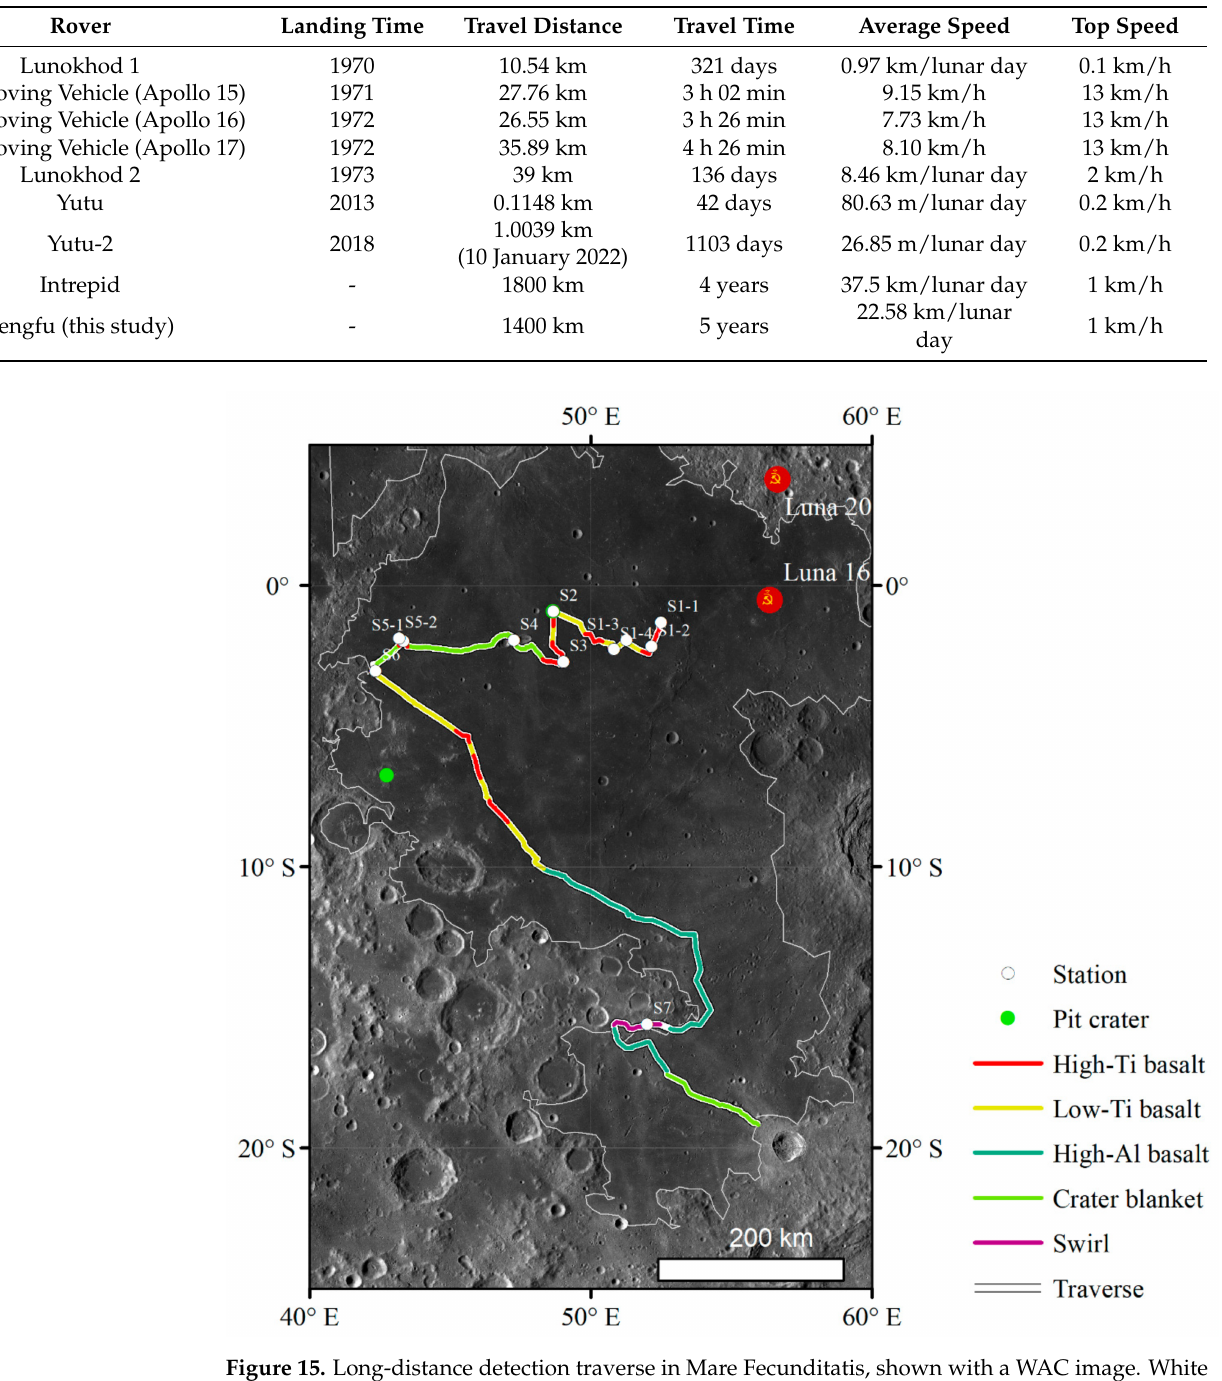
Table 1. Travel distance, time, and speed of previous lunar rovers, the Intrepid, and the Fengfu.